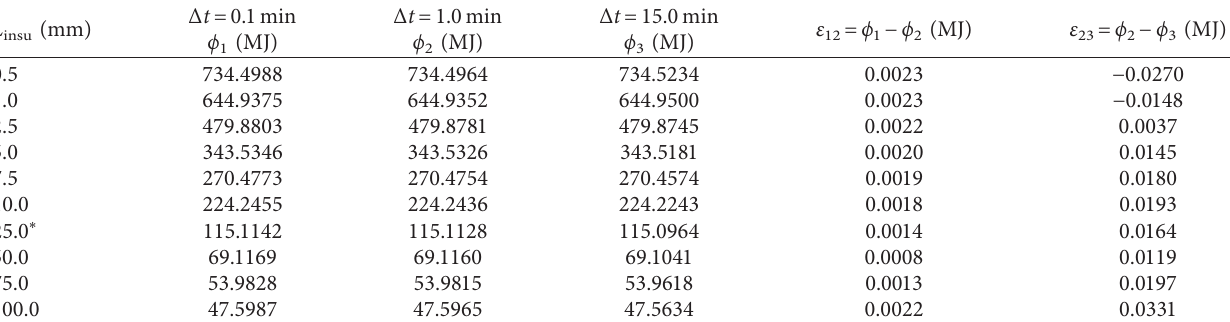
Table 5: Result of the time step independence study for the heat conduction energy gain by the thermal insulation during the kiln heating